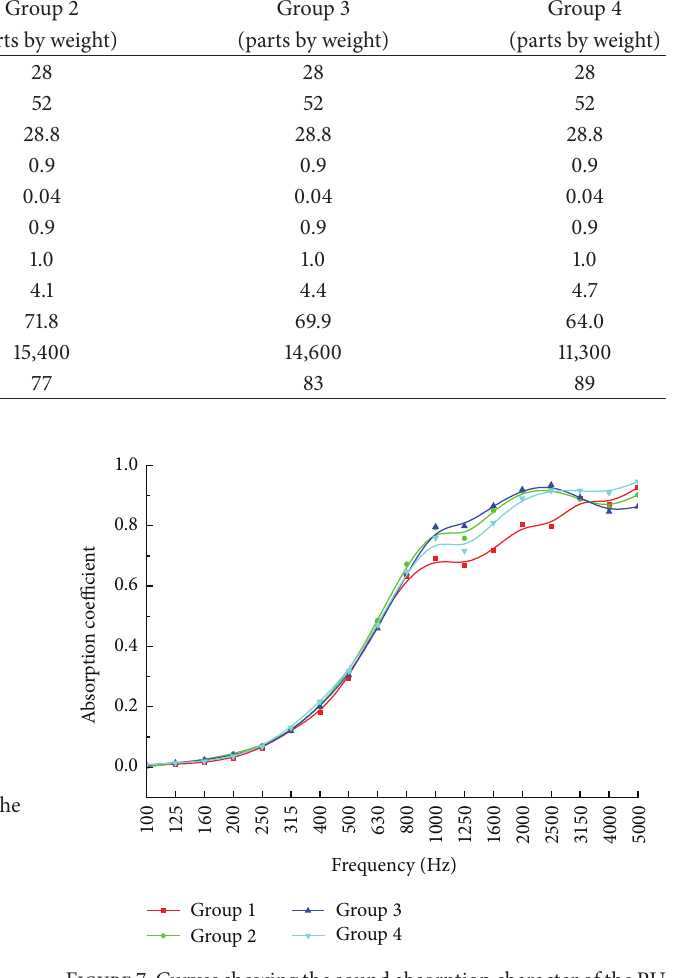
Figure 7: Curves showing the sound absorption character of the PU foams with varying water contents. (a) Group 1 with water 3.8 parts by weight, (b) Group 2 with water 4.1 parts by weight, (c) Group 3 with water 4.4 parts by weight, and (d) Group 4 with water 4.7 parts by